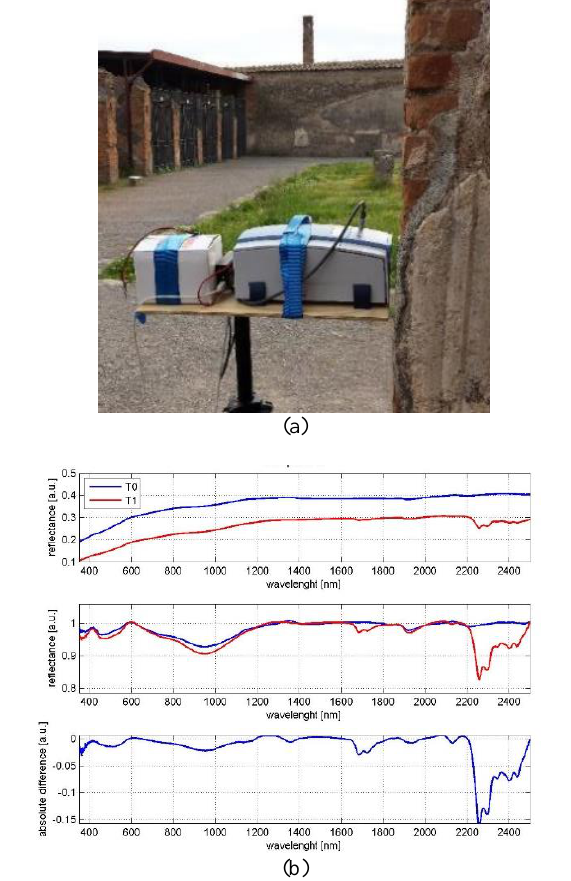
Figure 9. (a) Portable FTIR applied on the wall of the Macellum in the archaeological site of Pompeii; (b) Reflectance spectra on Campanian Ignimbrite before and after the treatment.